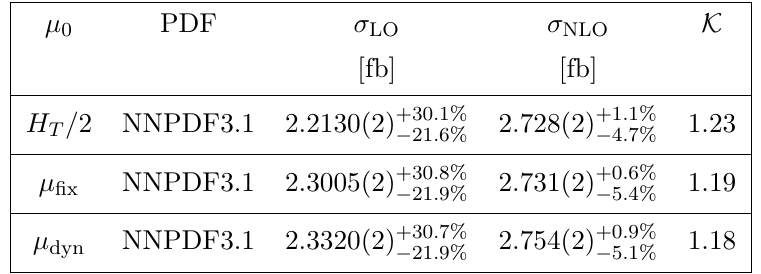
Table 2 . Integrated fiducial cross section at LO and NLO QCD for the pp → e + ν e µ − ¯ ν µ b ¯ b H process √ at the LHC with s = 13 TeV. Results are presented for µ 0 = H T / 2 , µ 0 = µ fix and µ 0 = µ dyn . The NNPDF3.1 PDF set is